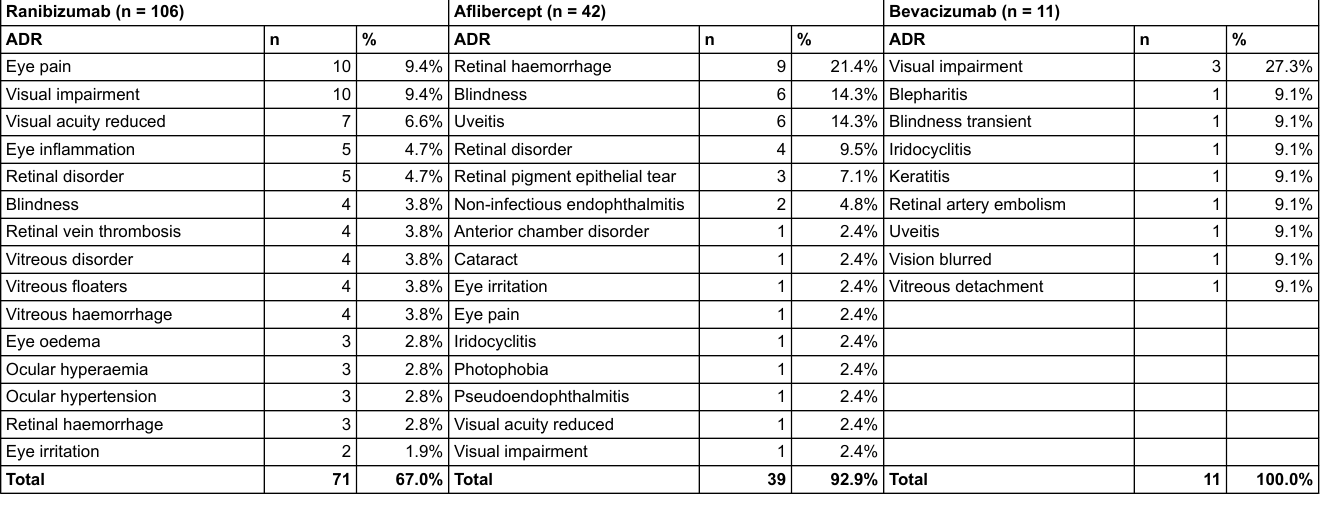
Table 3: Number and percentage of the first 15 most reported ADRs for ranibizumab, aflibercept und bevacizumab. Ranibizumab (n =